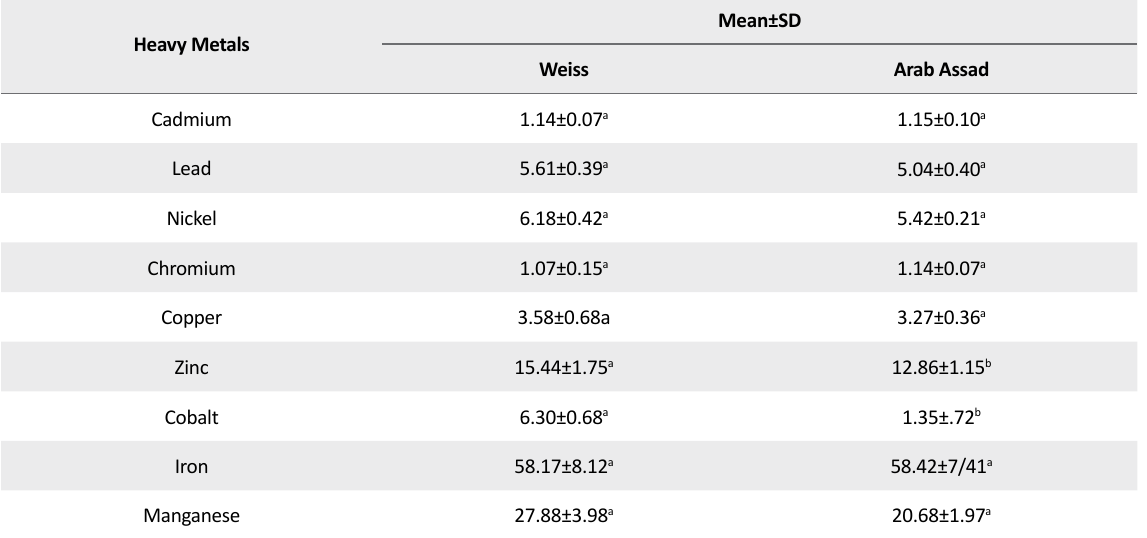
Table 5 . Pearson correlation of heavy metal concentrations in wheat of Weiss farms